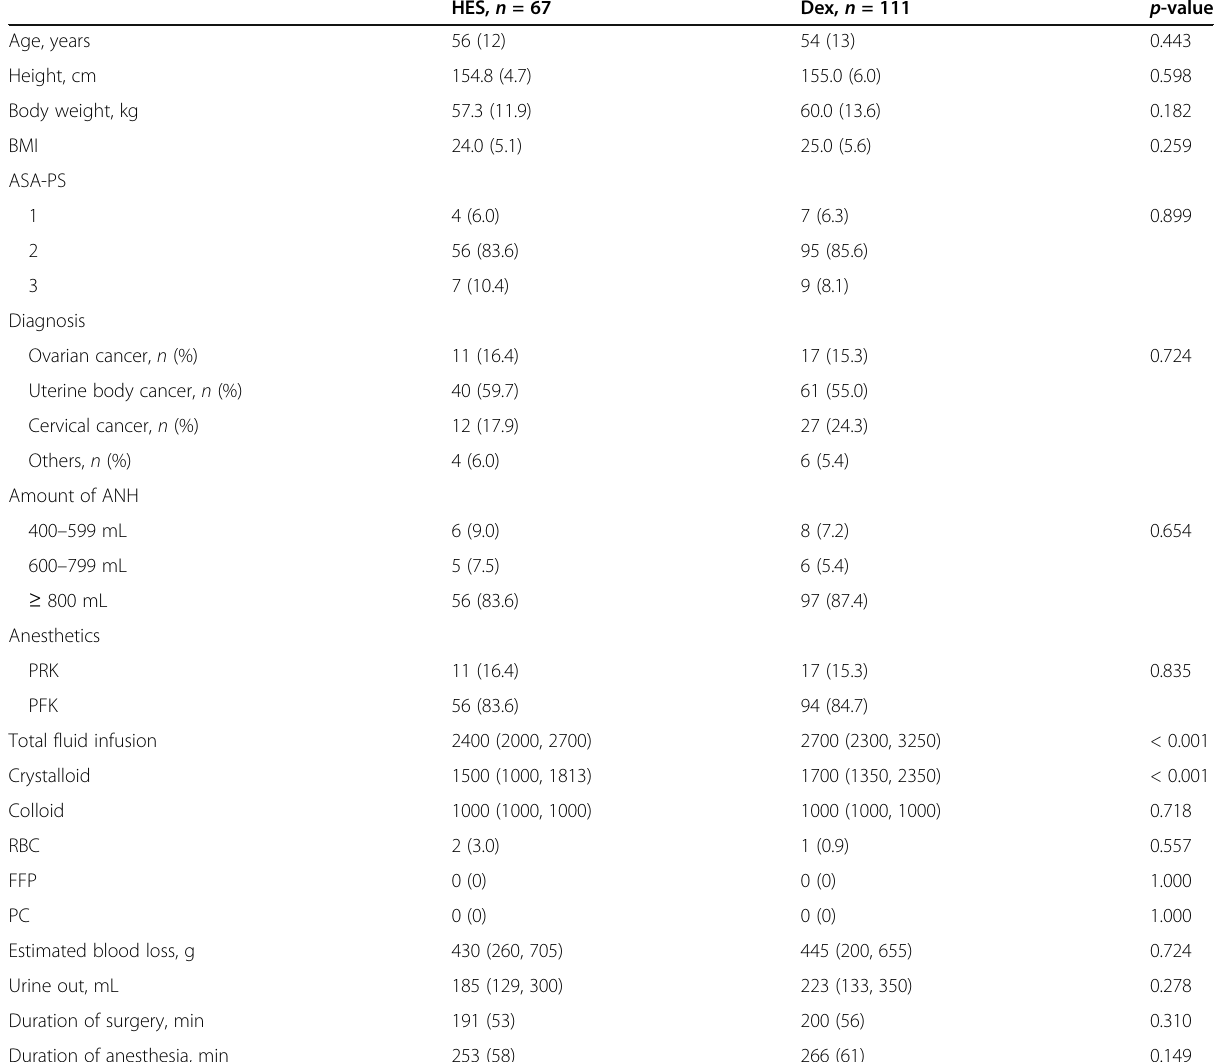
Table 1 The patients ’ characteristics and intra-operative